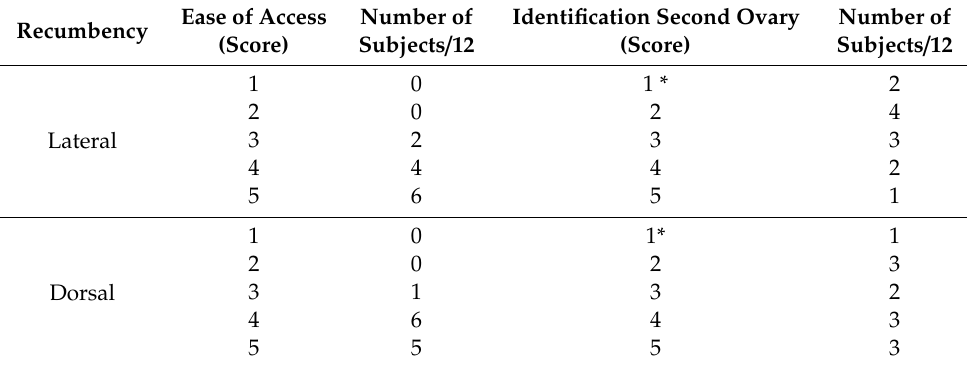
Table 3. The score record regarding ease of access to the coelom and ease of identification of the ovary opposite to the surgical